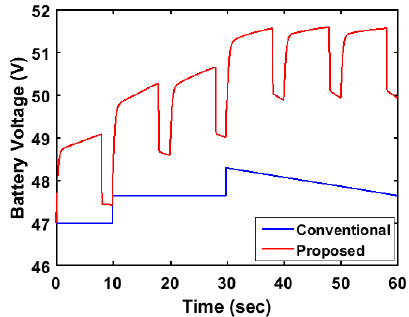
Figure 14. PV supply voltage at different atmospheric conditions.